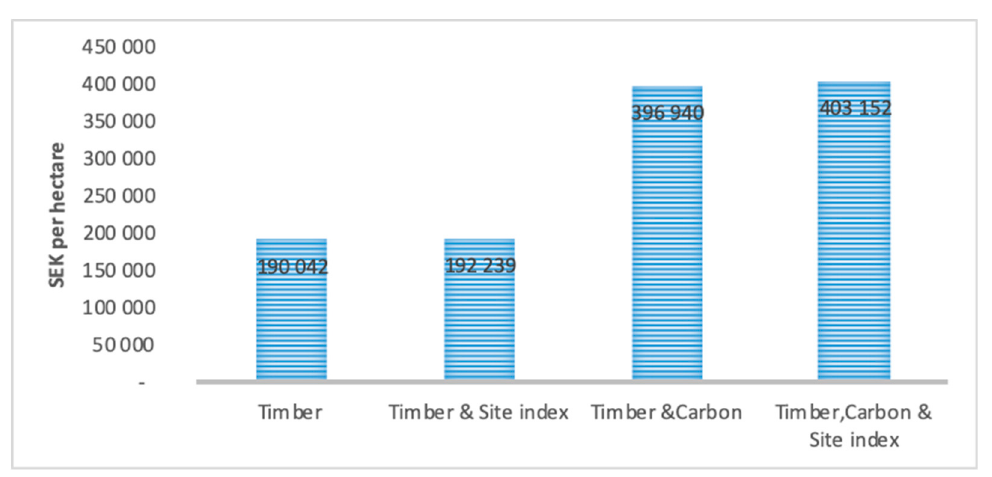
Figure 1. NPV of Swedish forest management under different cases in SEK a per ha; a (9.36 SEK = 1 Euro on average, in 2015).